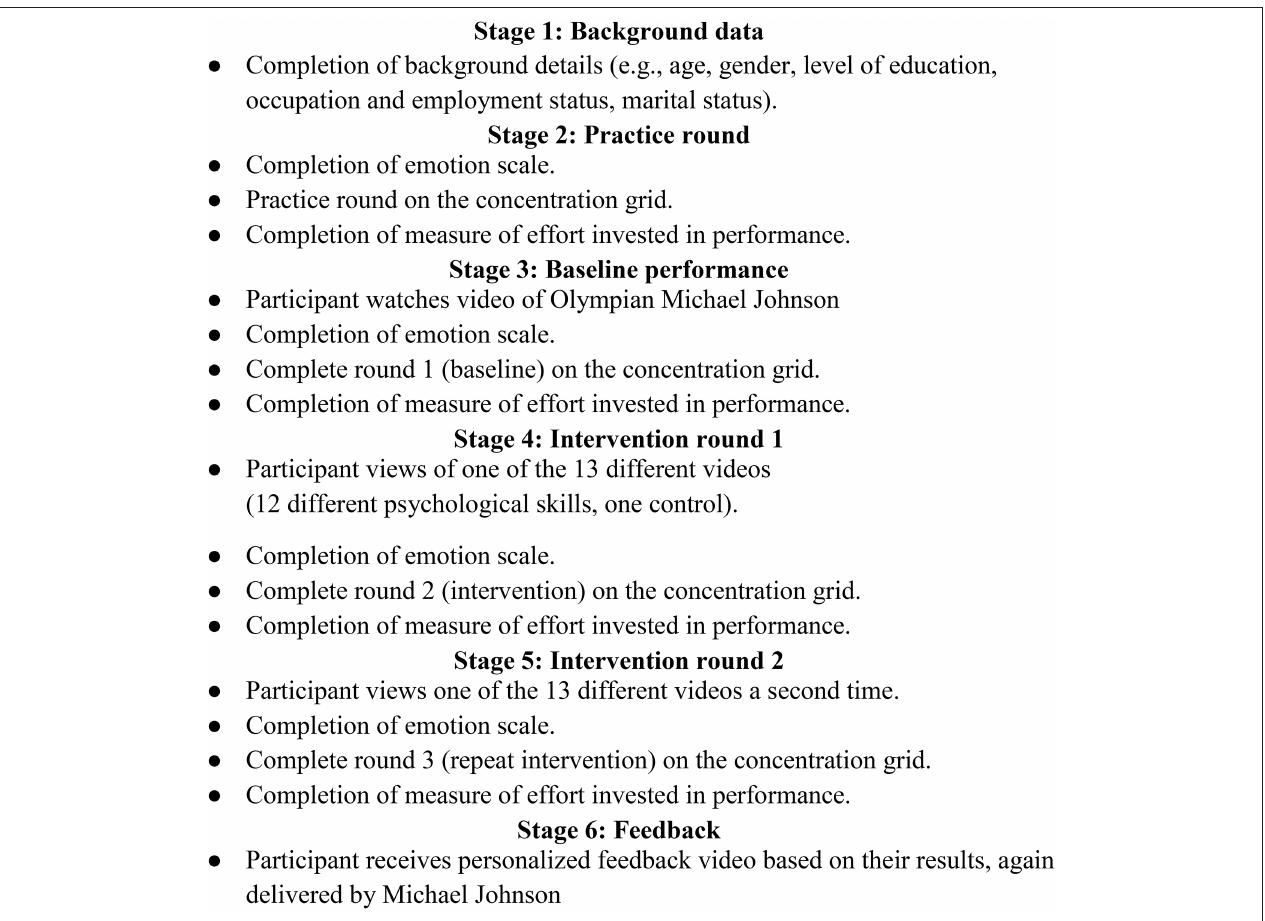
FIGURE 1 | Stages of the online